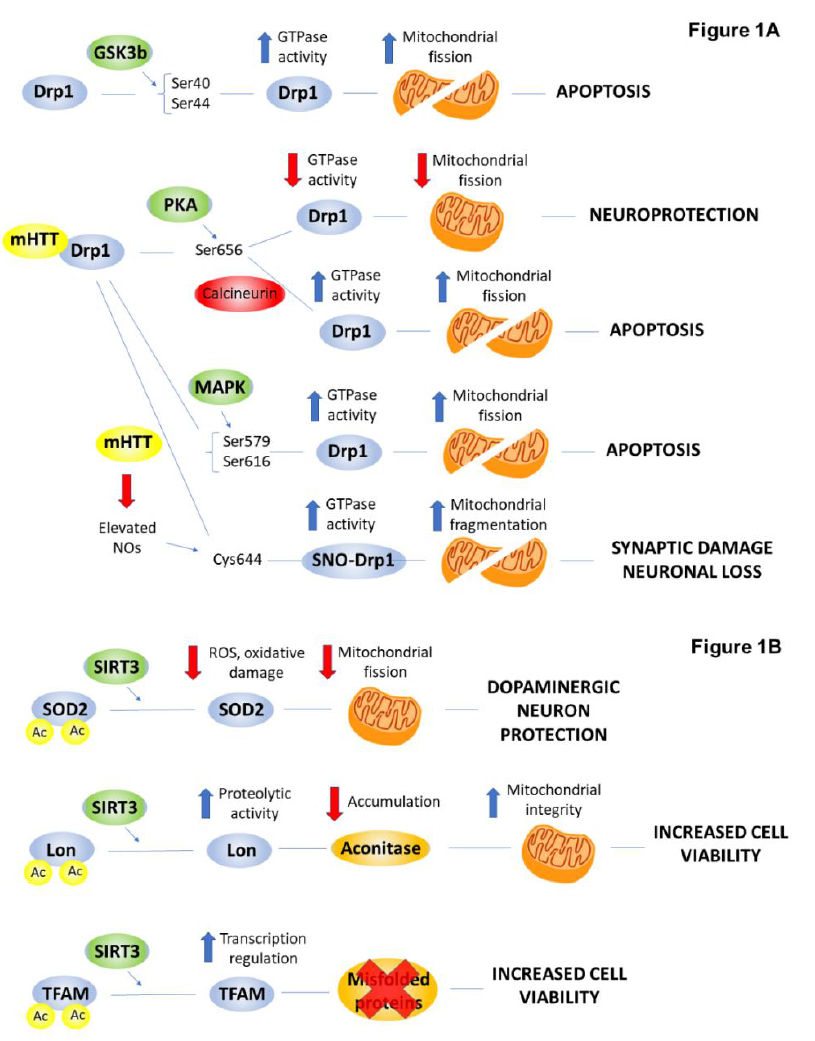
Figure 1. Recently identified post-translational modifications a ff ecting ( A ) mitochondrial dynamics and ( B ) mitochondrial biogenesis in HD. ( A ) Drp1, one of the key players in mitochondrial fission, can be phosphorylated at several Serine amino acid residues leading to imbalanced fission / fusion of mitochondria and determining cell fate in HD. ( B ) Mitochondrial biogenesis is also regulated by the deacetylase activity of the sirtuin SIRT3. SIRT3 prevents cells from mitochondrial dysfunction in HD. This compensatory mechanism was described in astrocytes of human HD striatum. The Phosphorylation of Drp1 at Ser-40 and Ser-44 by GSK- 3β promotes the GTPase activity of Drp1